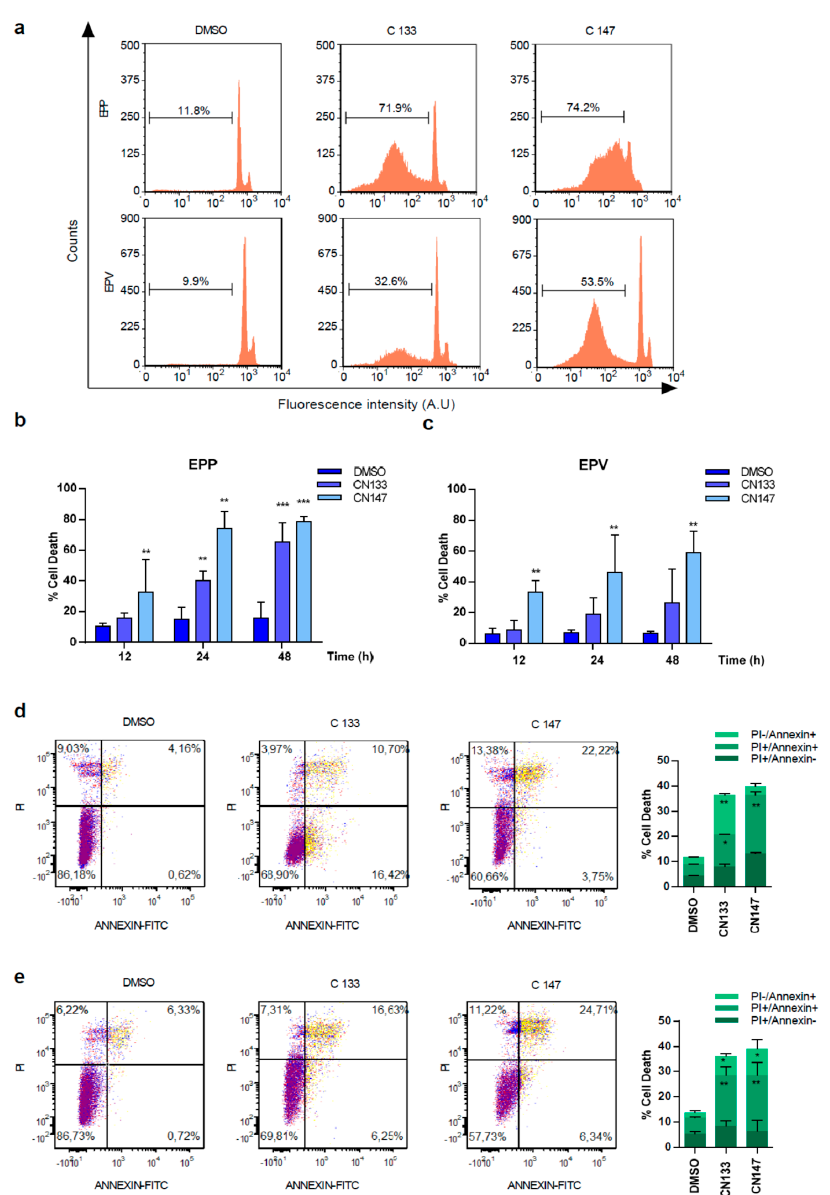
Figure 3. CN133 and CN147 induce cell death in EPN cell lines: ( a ) EPP and EPV cell lines were treated with 1 µM of CN133 and CN147 and apoptosis was evaluated by flow cytometry (FACS); ( b , c ) Graph represents the average quantification of the percentage of cells in sub-G1 of three independent experiments ( n = 3/experiment) ± SEM. ** p < 0.01; *** p < 0.001; EPP ( d ) and EPV ( e ) were treated with 1 µM of CN133 and CN147 for 24 h. At the end of the treatment, cells were harvested and stained with the Annexin V kit following the manufacturer’s instruction. Graph represent the average quantification ( n = 3/each). * p < 0.05; ** p < 0.01; *** p < 0.001.